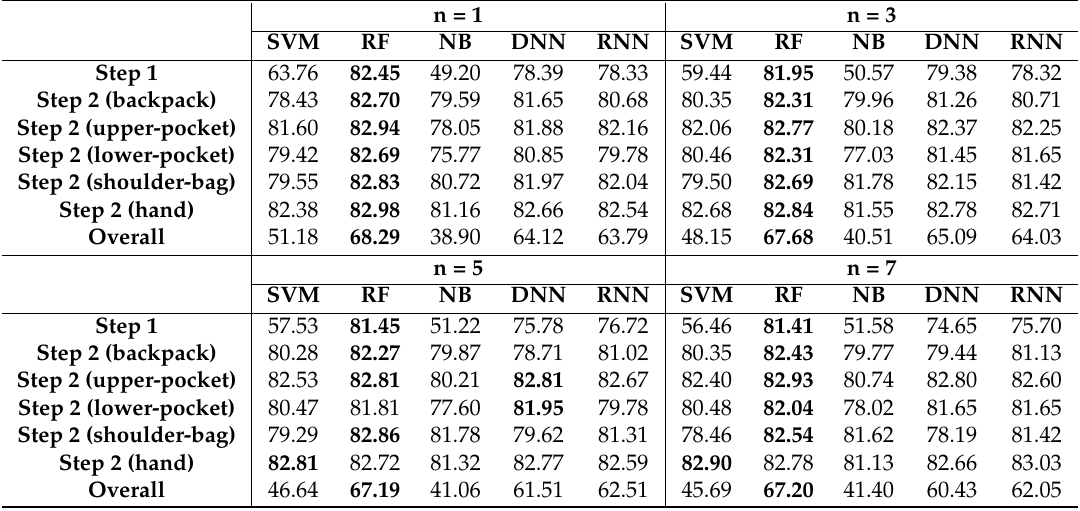
Table 4. Accuracies of possession-action recognition for different number of windows.